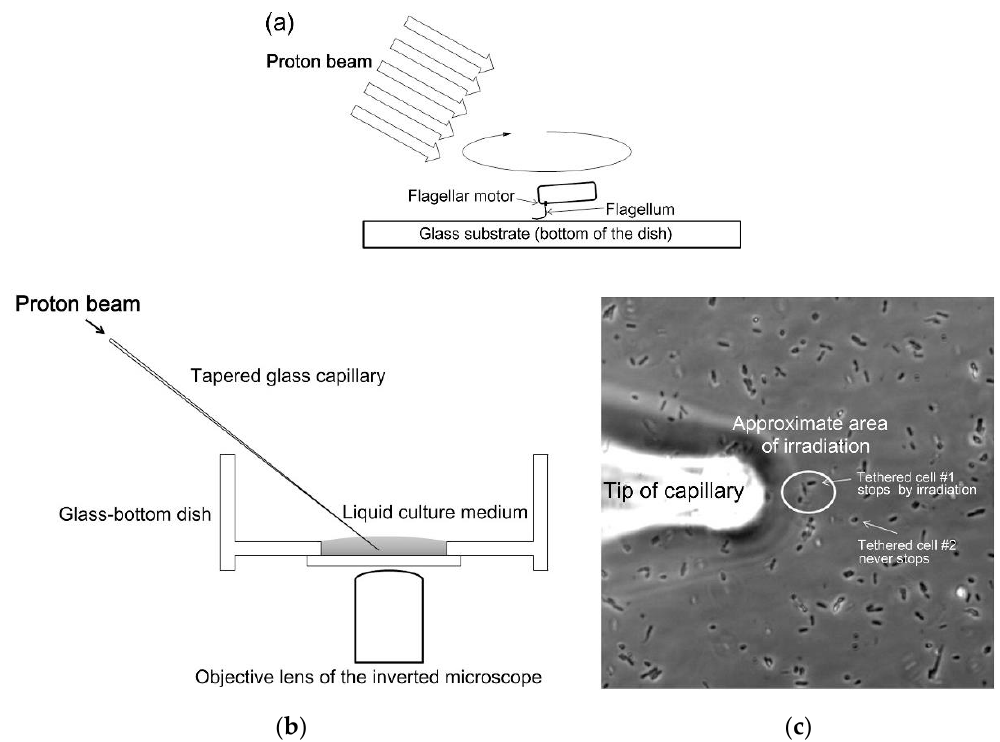
Figure 18. ( a ) Illustration of the tethered cell; ( b ) horizontal view of the apparatus; and ( c ) a typical irradiation. The cells within the ellipse were irradiated and other cells in the microscope view were negative controls. (Reprinted from [58], with the permission of AIP Publishing).